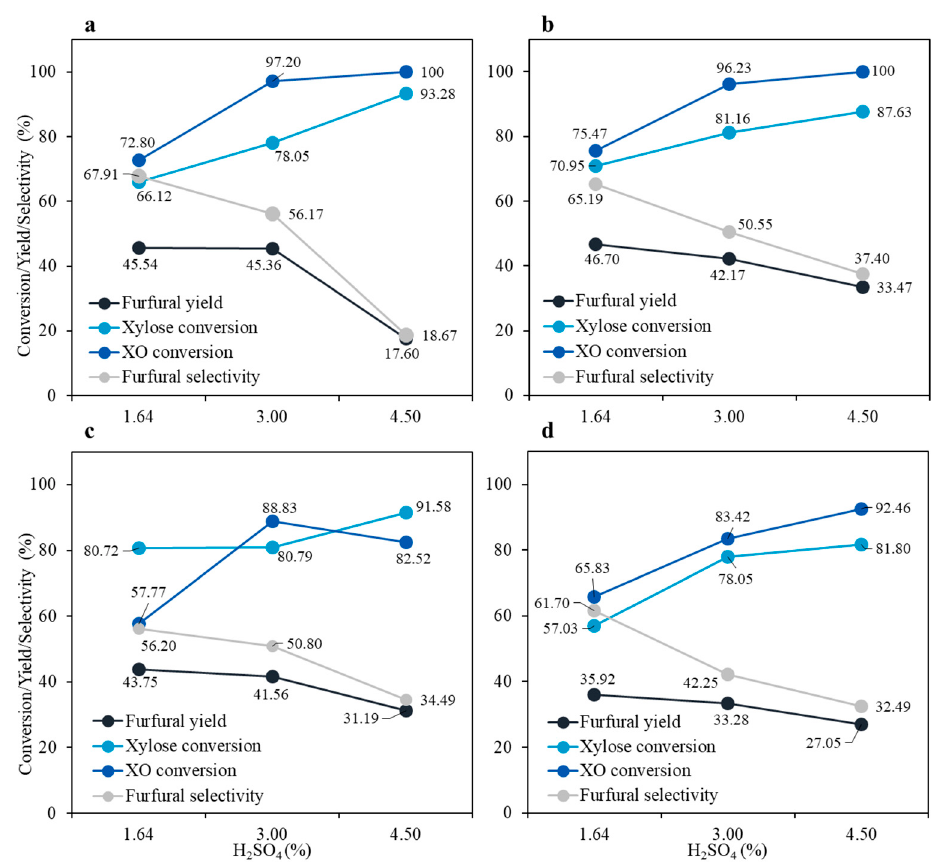
Figure 2. Xylose conversion, xylo–oligomer (XO) conversion, furfural yield, and furfural selectivity depending on CSF and H 2 SO 4 concentration ( a ) CSF 1.89, ( b ) CSF 1.92, ( c ) CSF 2.08, ( d ) CSF: 2.29.